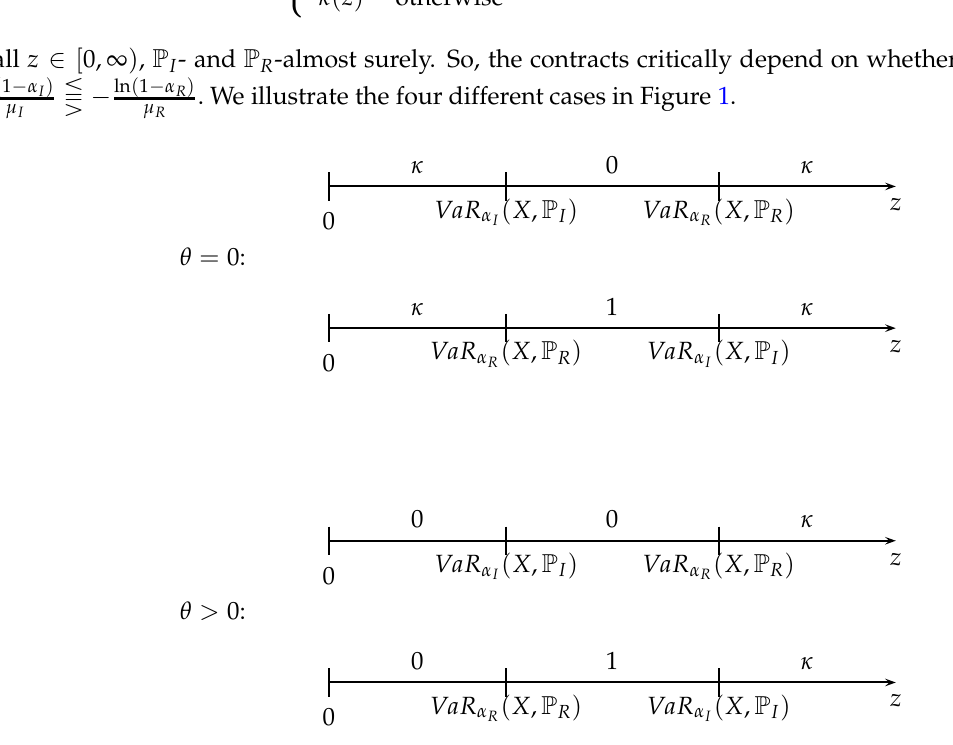
Figure 1. This figure graphically illustrates the optimal marginal indemnity function h ∈ H of Theorem 1 in case the Value-at-Risk (VaR) is used. The range of X , denoted by z ∈ [ 0, ∞ ) , is partitioned in sub-domains, and the value h ( z ) is shown above the relevant sub-domain. Recall that z f ( z ) = h ( s ) ds , and κ ( z ) is any measurable and [0,1]-valued function. The first two illustrations 0 R represent cases where θ = 0, and in the last two illustrations represent cases where θ > 0. ( X , P I ) ≤ VaR α ( X , P R ) , and the Moreover, the first and third illustration show the case that VaR α I R ( X , P I ) ≥ VaR α ( X , P R ) . second and last illustration show the case that VaR α I R The derived optimal reinsurance indemnities include layer-reinsurance. Proportional reinsurance is ( X , P ) = VaR α ( X , P ) both hold. In that case, however never optimal unless θ = 0 and VaR α I R I R every indemnity f ∈ F is optimal. If, for instance, we are at a realization z of X such that ( X , P ) < z < VaR α ( X , P ) , then marginal increases in risk at z will be irrelevant for VaR α R I R I ( X , P ) , but not for VaR α ( X , P ) . As a result, it is optimal to shift marginal risk to the reinsurer, VaR α R I R I i.e., h ( z ) =